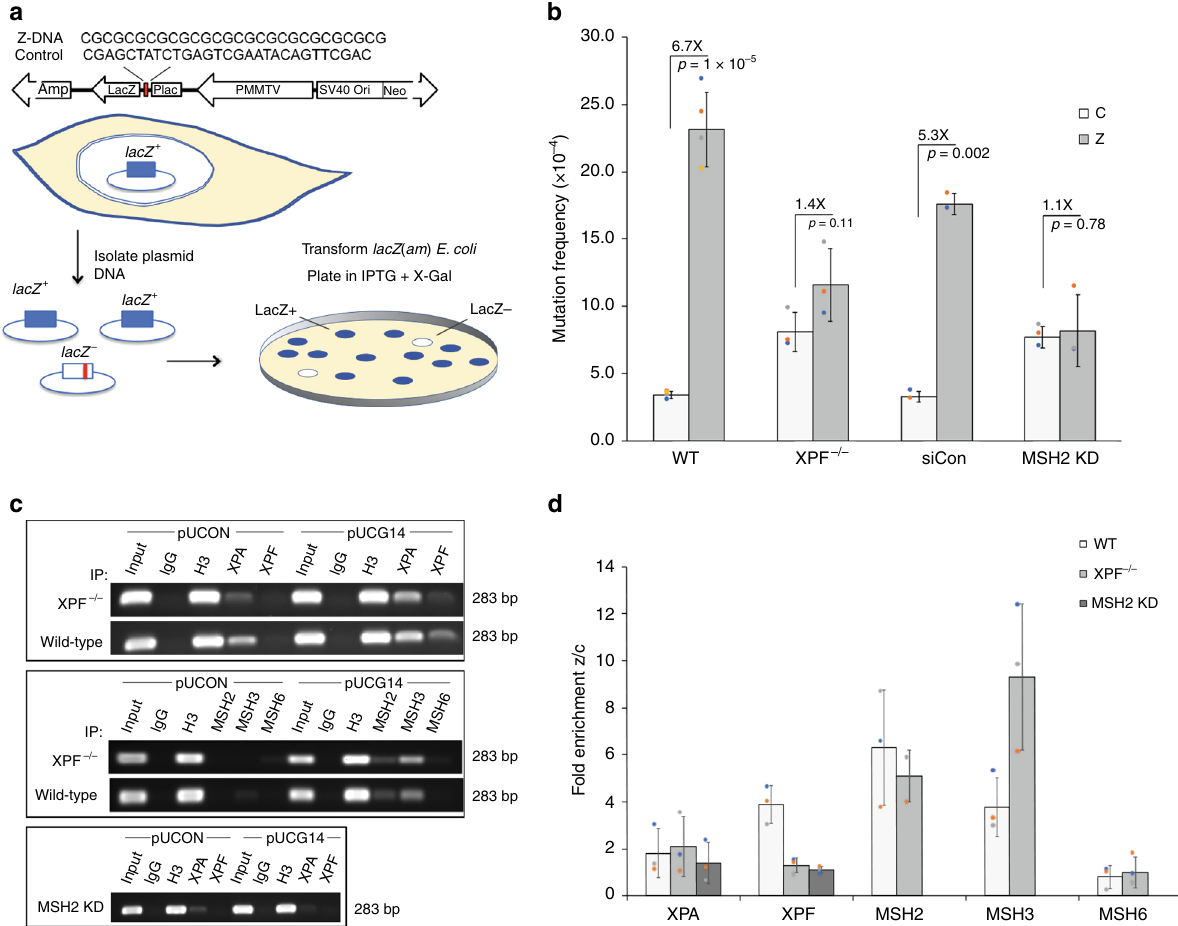
Fig. 2 ERCC1-XPF and MSH2-MSH3 are required for Z-DNA-induced mutagenesis in human cells. a Schematic of blue-white mutation assay (adapted from Vasquez et al. 61 ). b Mutation frequencies for WT, XPF-de fi cient, siRNA control, and siRNA-depleted MSH2 human cell lines. Student ’ s t -test was used to calculate statistical values. c Representative ChIP analysis performed on (pUCON and pUCG14) plasmids in WT and XPF-de fi cient human cells using antibodies against NER (top panel) and MMR (middle panel) proteins, and in MSH2-depleted cells (bottom panel). IgG and H3 served as negative and positive controls, respectively. d Quanti fi cation of ChIP analysis comparing the Z-DNA-forming sequence to the control B-DNA region (Z/C), normalized to input. Data in b , d are presented as means ± SEM of triplicate experiments, and values of each repeat are shown as dot plots on the bars. See also Supplementary Figs. 3 – 7, and Supplementary Table